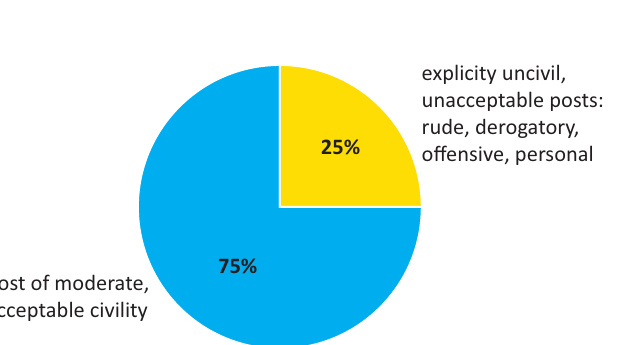
Figure 3. Civility on pro-government and independent media.